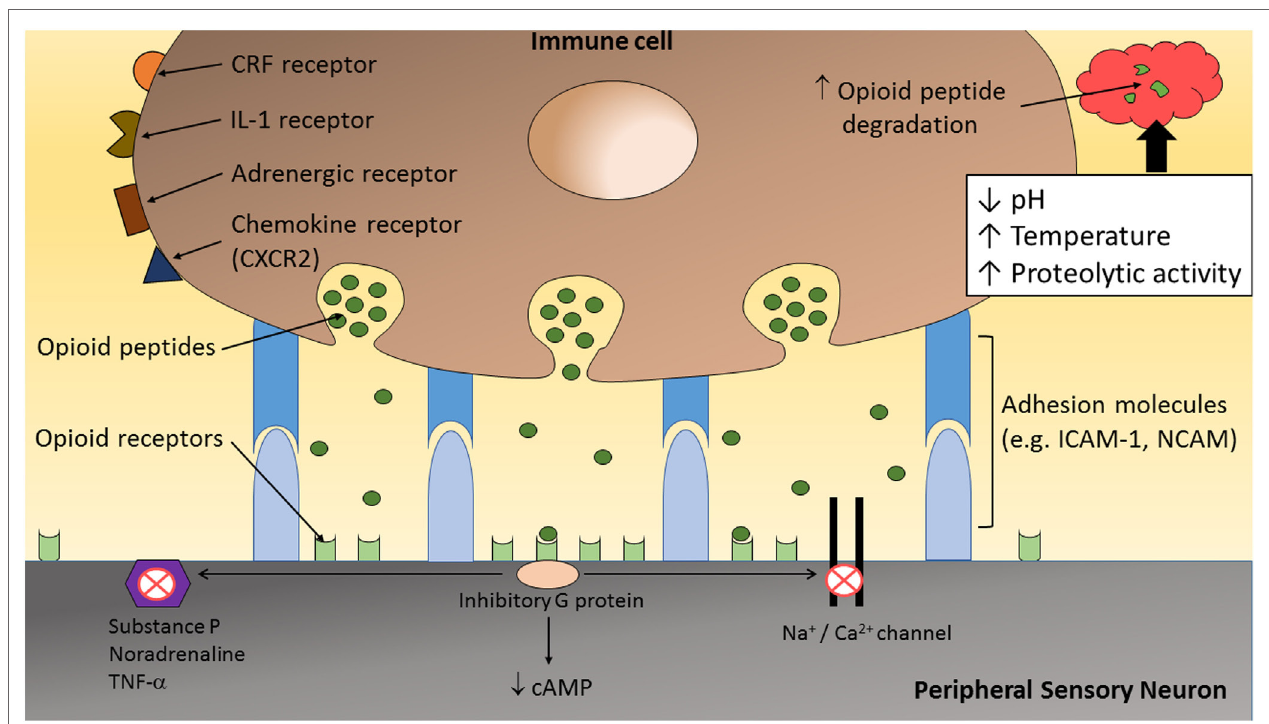
FiGURe 2 | The inflammatory milieu is associated with an increase in temperature, low pH, and high proteolytic activity, which together has been suggested to increase the degradation of opioid peptides (1, 23) . Therefore, direct adhesion between opioid-containing immune cells and peripheral sensory neurons, via adhesion molecules (e.g., ICAM-1 and/or NCAM), may be necessary to release opioid peptides within the effective range of peripheral opioid receptors to produce adequate analgesia. On activation by opioid agonists, opioid receptors undergo conformational changes allowing intracellular coupling of inhibitory G proteins to the C terminus of opioid receptors. This leads to inhibition of calcium and/or sodium channels and a decrease in the level of neuronal cAMP. In addition, opioids reduce the excitability of nociceptors, the propagation of action potentials, and the release of excitatory and/or pro-inflammatory factors (e.g., substance P, TNF- α , and NA) from peripheral sensory